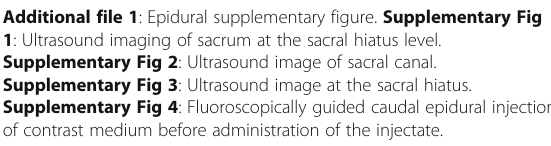
Supplementary Fig 2 : Ultrasound image of sacral canal. Supplementary Fig 3 : Ultrasound image at the sacral hiatus. Supplementary Fig 4 : Fluoroscopically guided caudal epidural injection of contrast medium before administration of the